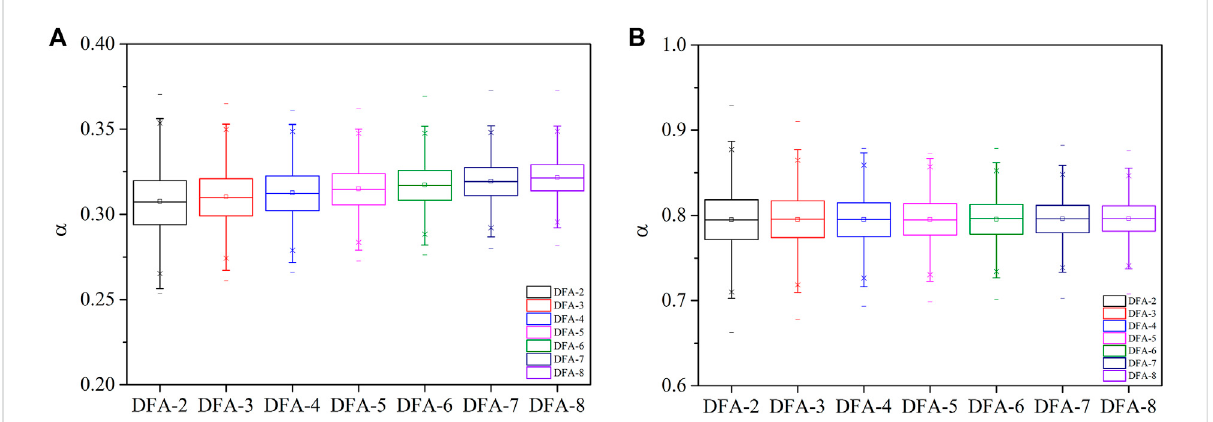
FIGURE 1 The box chart for DFA-n tests and the actual scaling exponents of the time series is 0.3 (A) and 0.8 (B) .